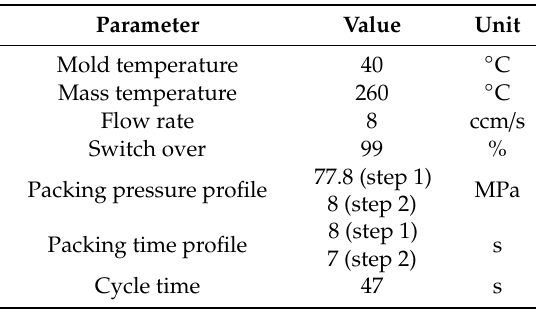
Table 3. Settings in AMI ® 2019.